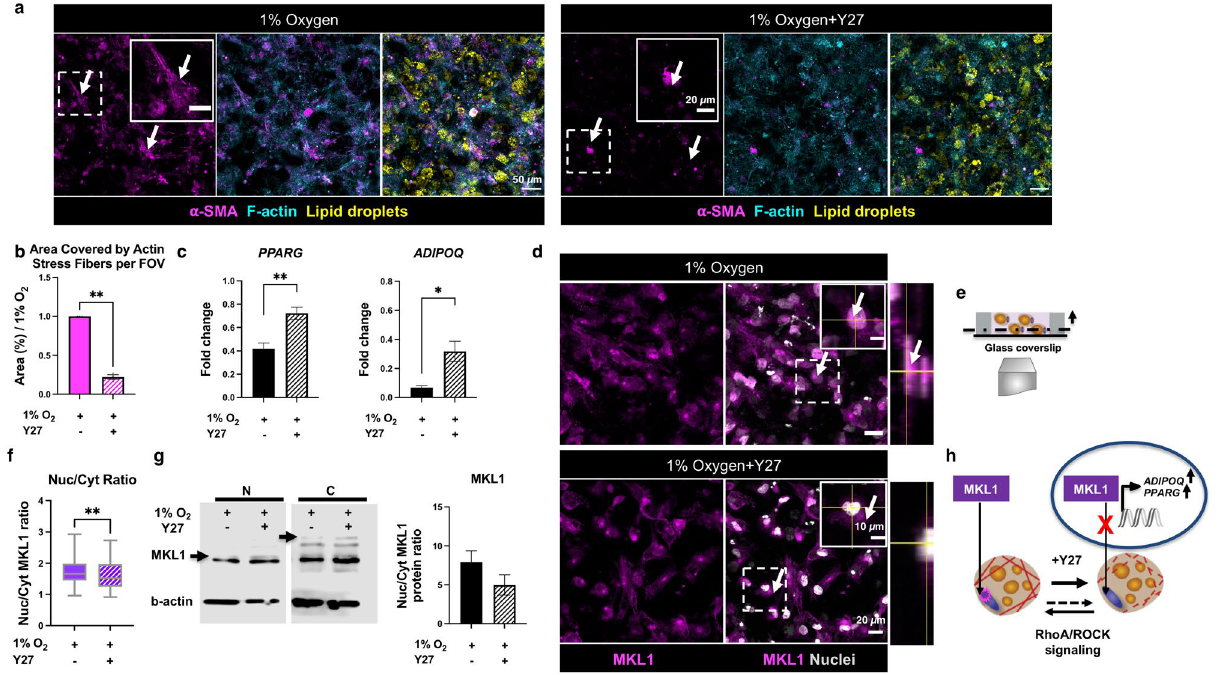
Figure 5. Y27 treatment partly attenuates hypoxia effects by inhibiting MKL1 nuclear translocation. ( a ) Fluorescent confocal microscopy images of the mono-culture AT constructs after 7 days in 1% oxygen without (top left panel) and with (top right panel) Y27 treatment, arrows point to ⍺ -SMA signal (scale bar-50 µm, insets-20 µm). ( b ) Actin stress fiber morphology was changed after Y27 treatment (n = 3 biological replicates). ( c ) Adipogenic ( ADIPOQ, PPARG ) genes were partly rescued towards a normoxic phenotype after Y27 treatment (n = 4–8 biological replicates, data are normalized to mono-culture samples maintained in 20% oxygen). ( d ) Fluorescent confocal microscopy images of the mono-culture AT constructs and the orthogonal view in 1% oxygen before and after Y27 treatment, arrows point to MKL1 signal localization (scale bar-20 µm, insets-10 µm). ( e ) Cross-section of AT constructs, fluorescent confocal microscopy images were taken at least 20 µm above the glass coverslip. ( f ) The nucleus to cytoplasm ratio for MKL1 was significantly decreased after Y27 treatment (n = 5 biological replicates, 20 cells per replicate). ( g ) MKL1 nuclear to cytoplasmic protein ratio in 1% oxygen and after Y27 treatment, arrows point to the quantified MKL1 protein bands (n = 3 biological replicates, cropped blot is shown, full length blot is presented in Supplementary Fig. S6). ( h ) Y27 treatment disrupts actin stress fibers due to MKL1 nuclear translocation inhibition, and this process is regulated via RhoA/ ROCK signaling pathway. Data are presented as means ± SEM. Comparisons between groups and statistical analysis were performed using unpaired Mann–Whitney test with two-tailed p-values (*p < 0.05, **p <